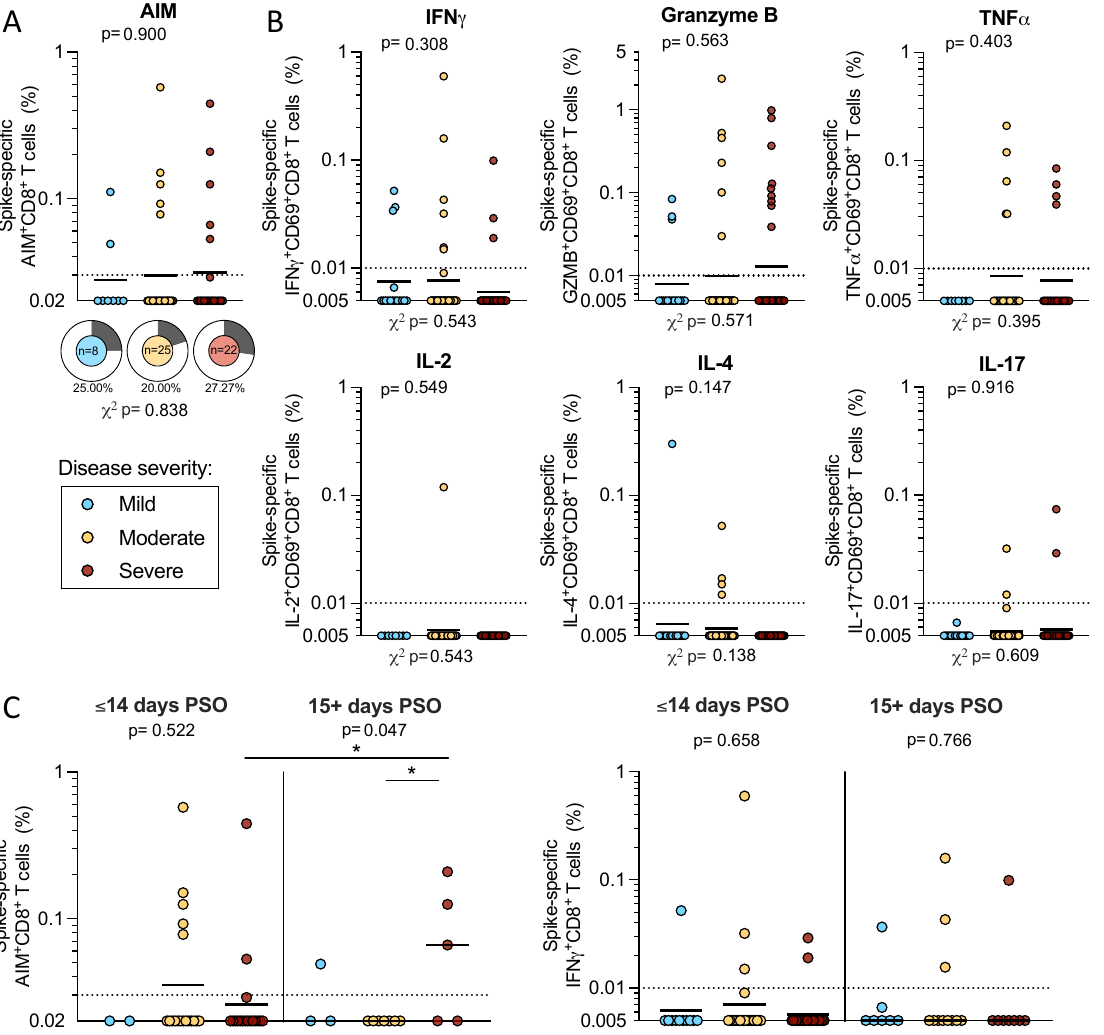
Figure 3. CD8+ T cell responses to SARS-CoV-2 spike in acute COVID-19 donors. PBMCs from acute COVID-19 donors were tested in an AIM + ICS assay for CD8+ responses to SARS-CoV-2 S. ( A ) CD69 + CD137+ AIM + CD8 T cells were quantified in a subset of the total cohort ( n = 8 mild, 25 moderate, and 22 severe). The frequency of responding donors is indicated by pie charts. ( B ) Spike-specific CD8+ T cell responses to IFN γ , granzyme B, TNF α , IL-2, IL-4, or IL-17 were double positive for CD69. ( C ) AIM+ and IFN γ CD8+ T cell responses were separated by less than 2 weeks or greater than 15 days PSO (3 mild and 1 severe were excluded from the graph because the days PSO was not reported). All data shown is background subtracted and SI > 2. Lines represent the geometric mean and the dotted line represents the limit of sensitivity (LOS), while the y-axis begins at the LOD. p -values are calculated by Kruskal–Wallis one-way ANOVA and, when significant, further Mann–Whitney U tests are applied between disease severities and significant results are indicated by the symbols. Chi-square test ( χ 2 ) p -values indicated below the pie charts are calculated from the frequency of response. * p <